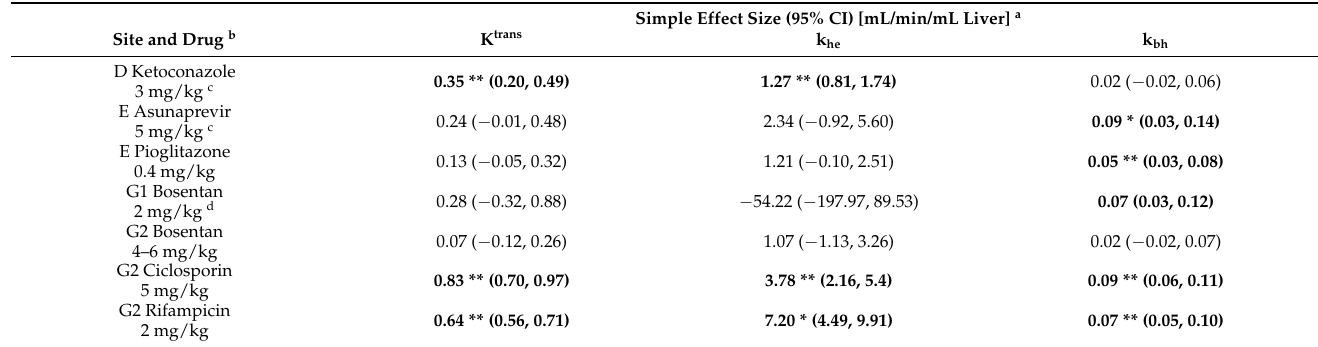
Table 5. Absolute effects of drugs on hepatic plasma clearance (K trans ), hepatic uptake (k he ), and biliary efflux (k bh ) of gadoxetate as estimated using the tracer-kinetic model. Any statistically meaningful changes (where zero falls outside of the 95% CI) are marked using bold